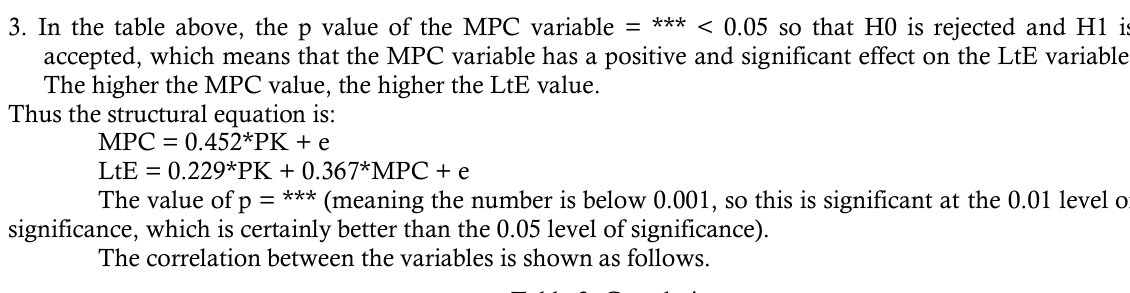
Table 3. Correlation